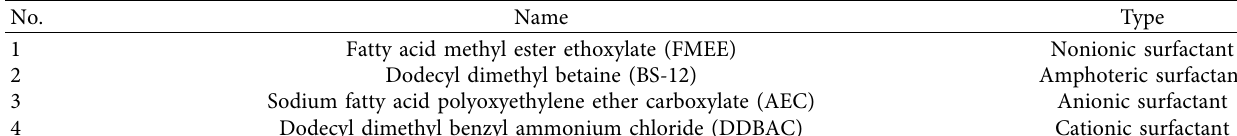
Table 1: Names and types of surfactants for experiments.